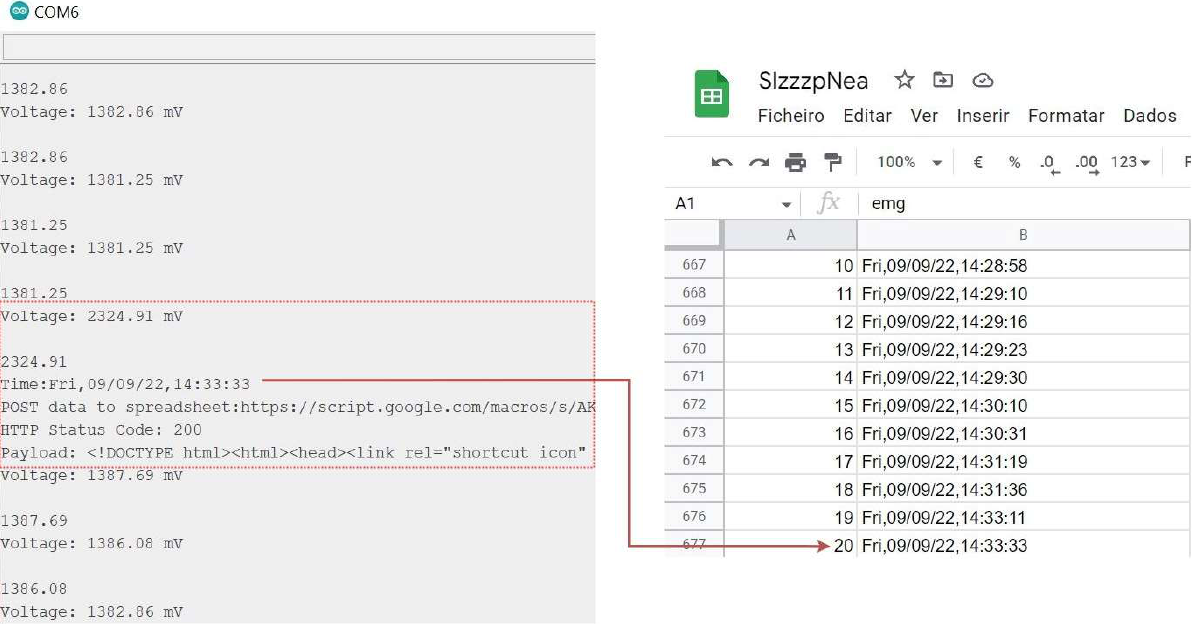
Table 1 . Relationship between threshold and average impulse voltage values.